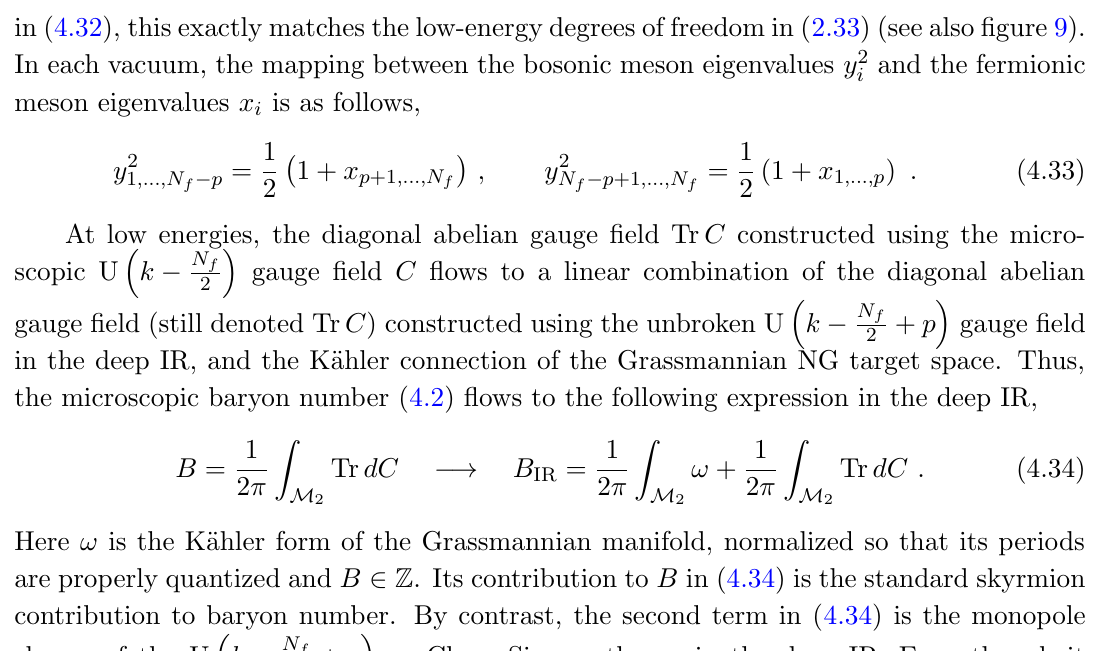
N f Figure 9 . Phases of large- N QCD as a function of the (cid:13)avor-singlet 3 (shown in blue) with k (cid:21) 2 mass m . There are N f + 1 phases, which generically contain both NG bosons (with Grassmannian target spaces) associated with di(cid:11)erent patterns of (cid:13)avor-symmetry breaking, as well as a Chern- Simons TQFT in the deep IR. There are N f (cid:12)rst-order phase transitions indicated by yellow dots. The same phases and transitions are captured by the bosonic dual (shown in red), if the scalar potential for (cid:30) takes a suitable